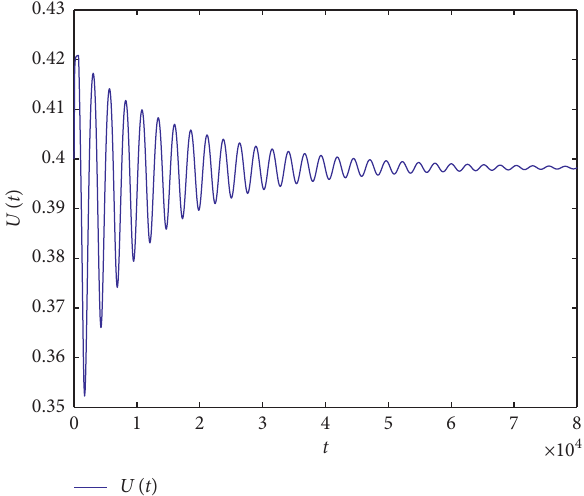
Figure 1: Time series solution of system (30) with ϕ � 0 . 90, � 728 . 403. τ � 700 < τ 0